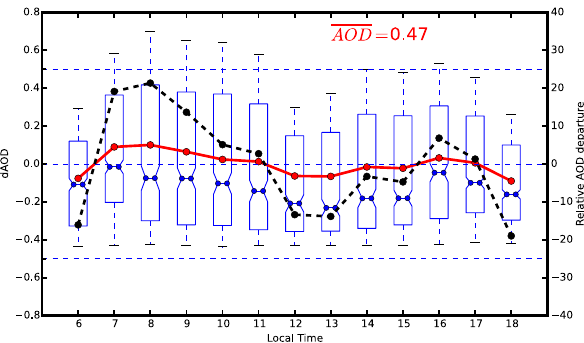
Figure 1. The average diurnal pattern of AOD at 550nm from AERONET measurements, Xianghe summer. Red line represents the absolute AOD departures (dAOD) from daily mean. Box plots give absolute AOD departure range from 25th to 75th percentile, and bars outside the boxes give the range within 5th to 95th per- centile; the blue dots in the box are medians. Black solid points give the relative departures in the right